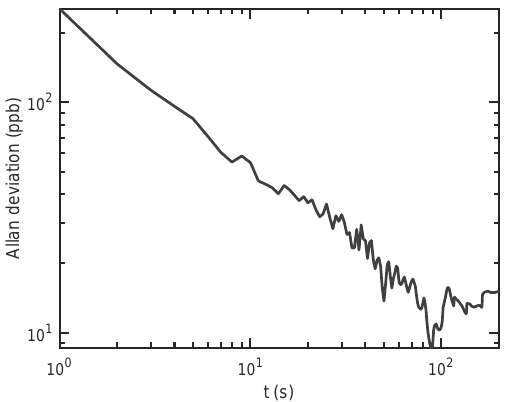
Figure 7. Allan deviation of the photothermal signal in units of NO 2 concentration as a function of averaging time. Allan deviation was calculated with